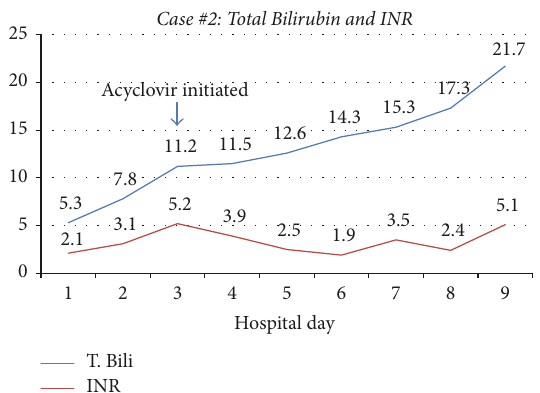
Figure 2: Case #1 trend in Total Bilirubin and INR. T. Bili: Total Bilirubin; INR: International Randomized Ratio.